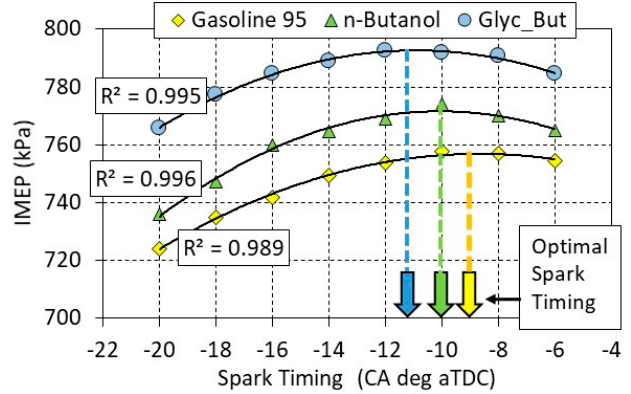
Figure 5. IMEP vs. spark timing for the tested fuels.